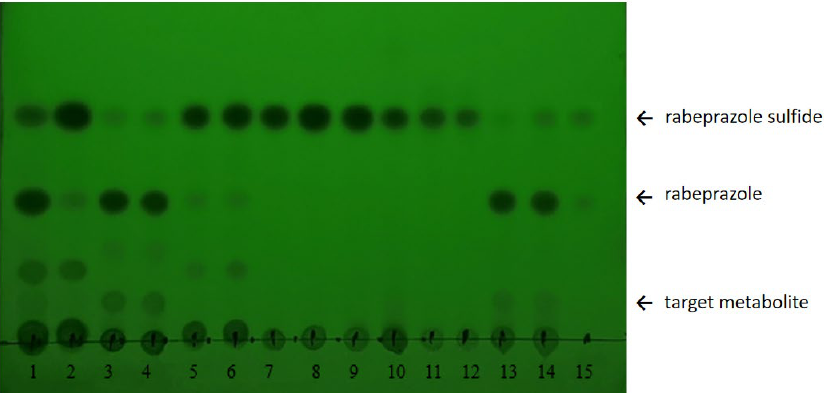
Figure 2. TLC screening results for seven strains of filamentous fungi for rabeprazole sulfide. Lanes 1 and 2, Cunninghamella elegans 3.910, 3 and 4, Cunninghamella echimnulata 3.967, 5 and 6, Absidia coerulea 41,050, 7 and 8, Gibberella sp. 2498, 9 and 10, Caldariomyces fumago 16,373, 11 and 12, Gibberella fujiluroi 40,272, 13 and 14, Cunninghamella blakesleeana 3.970, and 15, standard mixture of rabeprazole sulfide and rabeprazole.